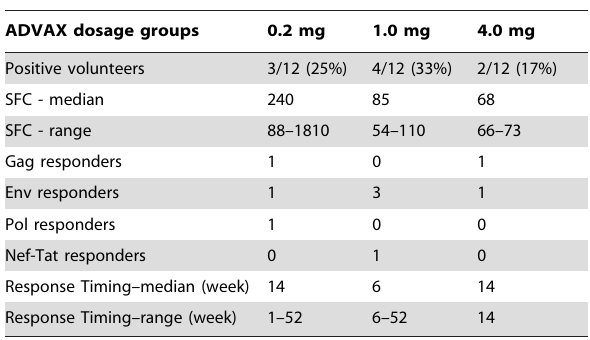
Table 3. IFN c ELISpot Results.